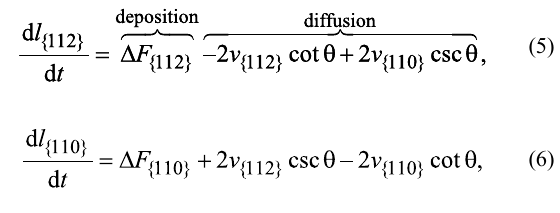
l {112} / l {110} ≈ Δ F {112} / Δ F {110} = 0.202 (Figure 4b). This